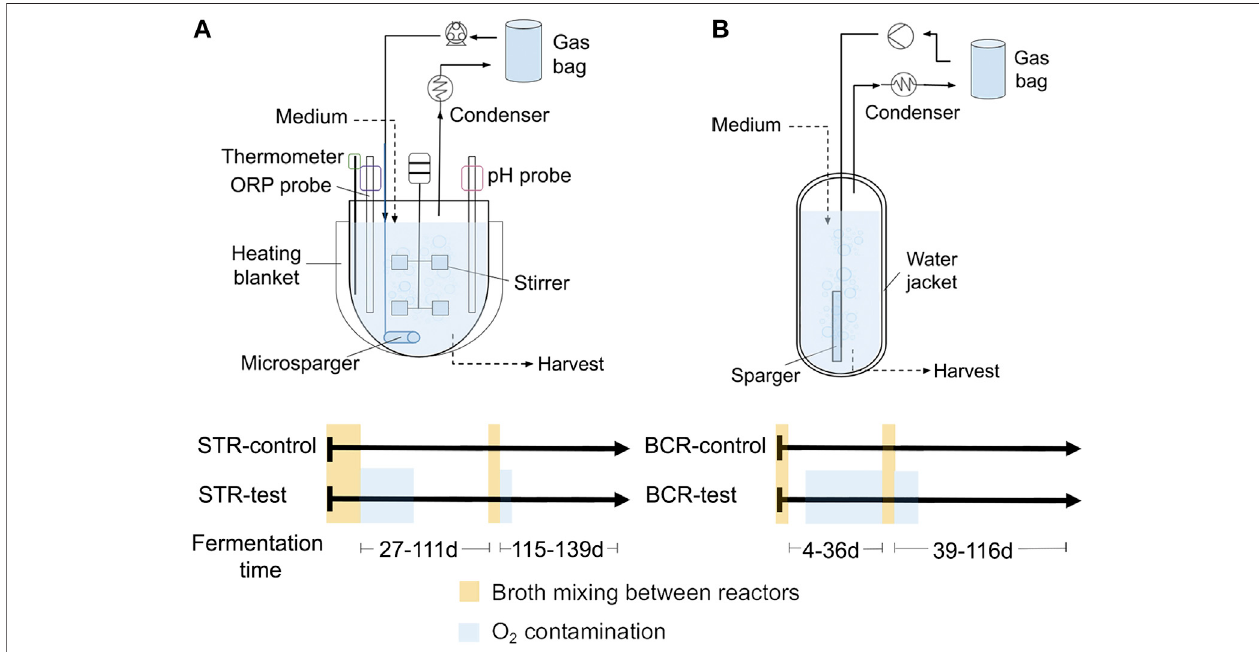
FIGURE 1 | Gas recirculation reactors used in the study. Stirred tank reactors (STRs) (A) and bubble column reactors (BCRs) (B) with their respective timelines of events for each reactor.